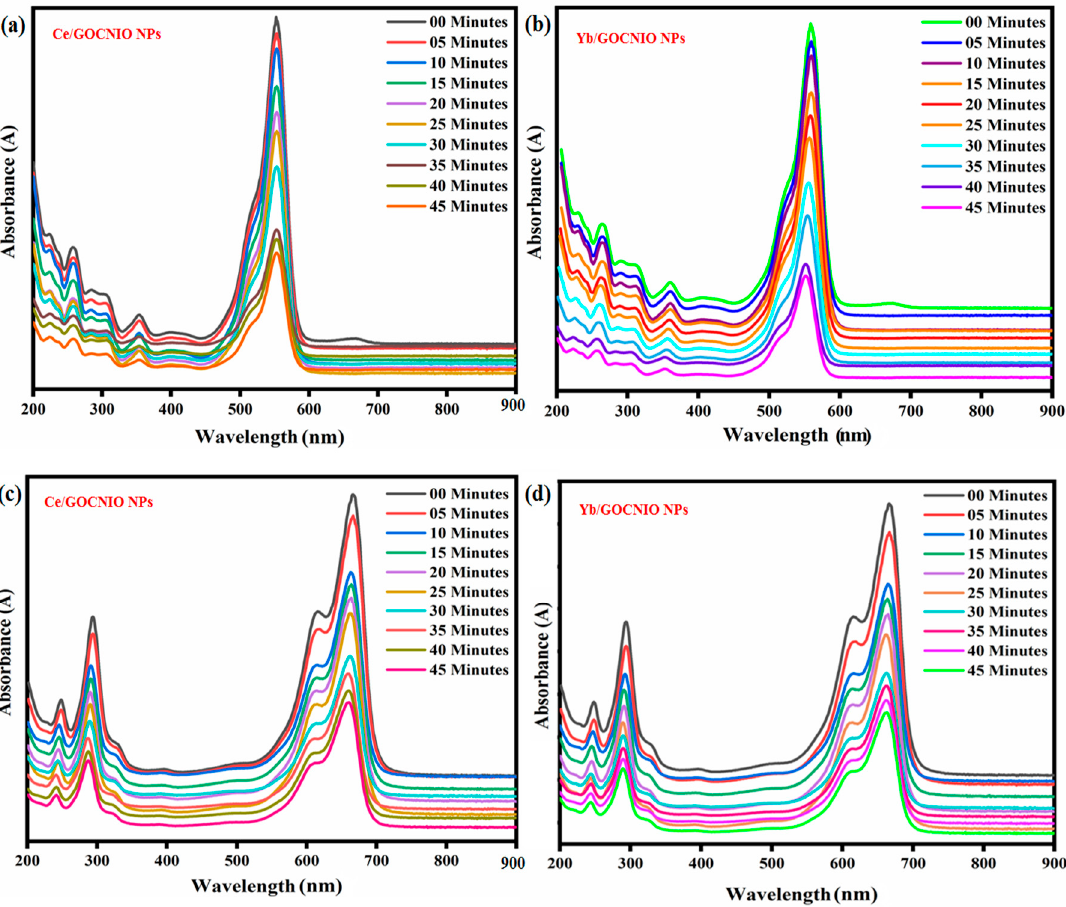
Figure 6. Percentage of degradation of RhB dye by ( a ) Ce/GOCNIO NPs, ( b ) Yb/GOCNIO NPs; Percentage degradation of MB dye by ( c ) Ce/GOCNIO NPs, ( d ) Yb/GOCNIO NPs.